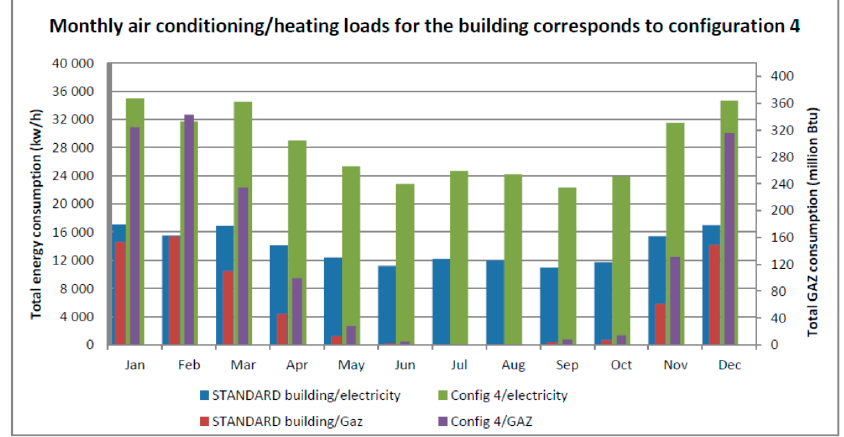
Figure 12. Monthly air conditioning / heating loads required to maintain the thermal comfort for the configuration 4 building compared to the loads required for the standard building.